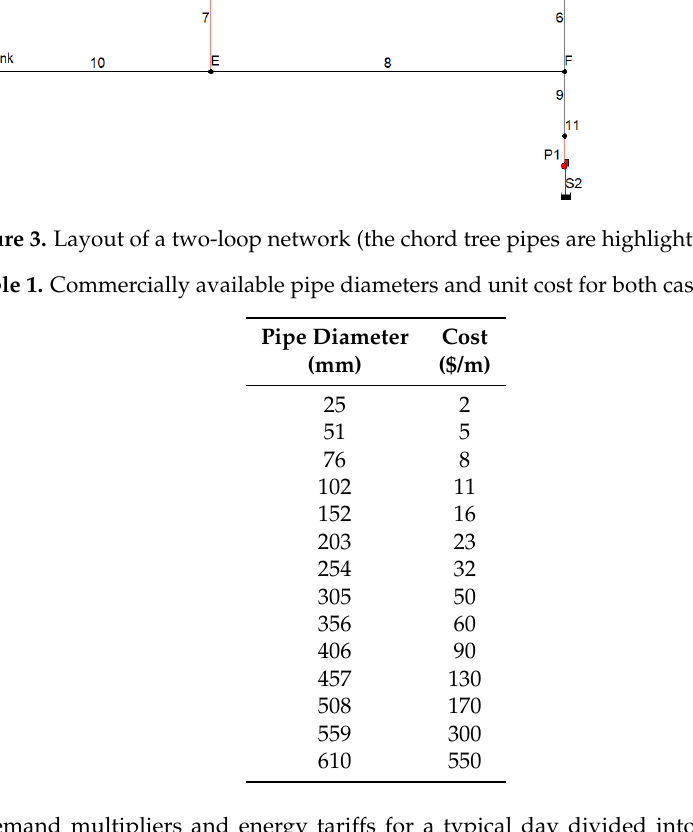
Table 2. Demand multipliers and energy tariffs for a typical day divided into four, six, and 12 loading